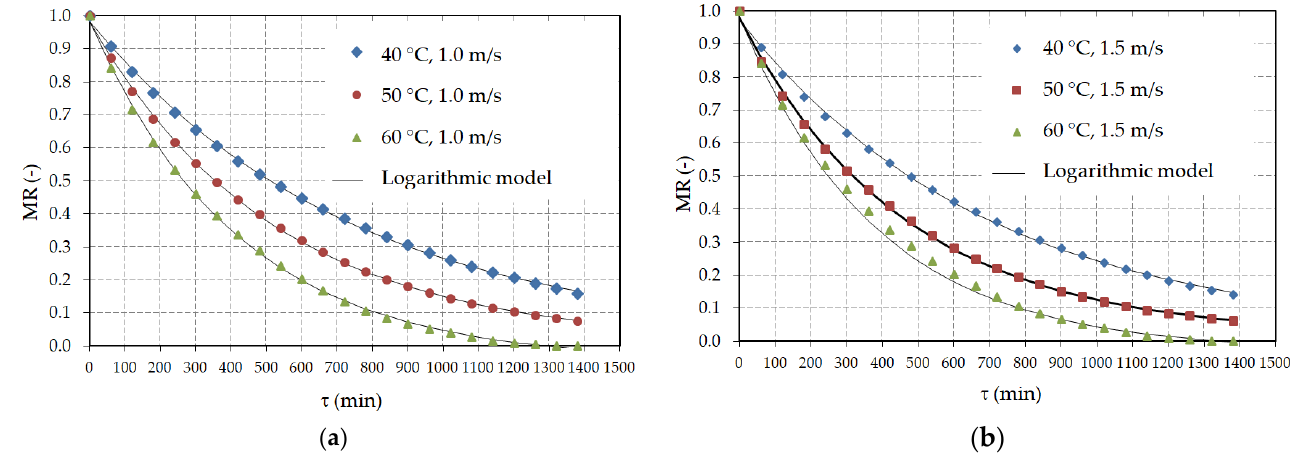
Figure 4. Drying curves of the hot air drying process of the apricot halves with osmotic pretreatment OD1 (40 °C, 50%): ( a ) air velocity 1.0 m/s, ( b ) air velocity 1.5 m/s.